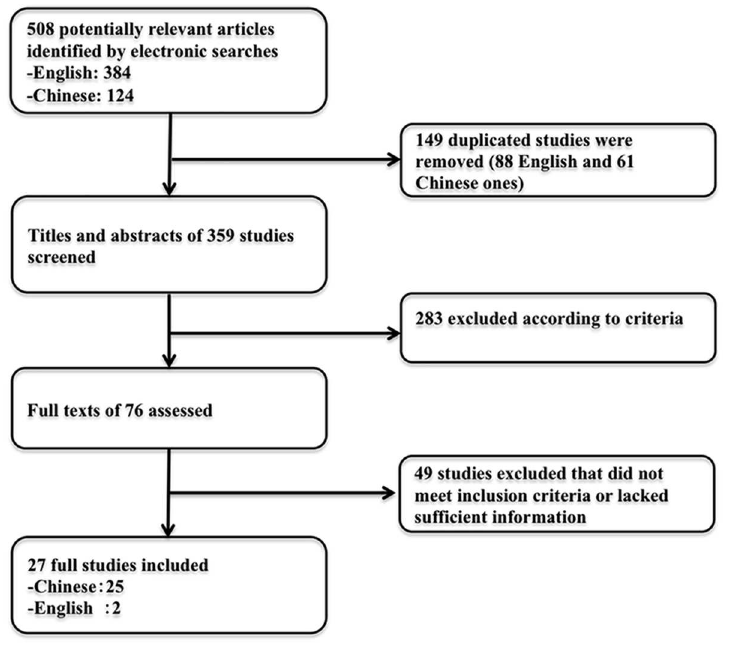
Fig 1. Flow diagram of articles